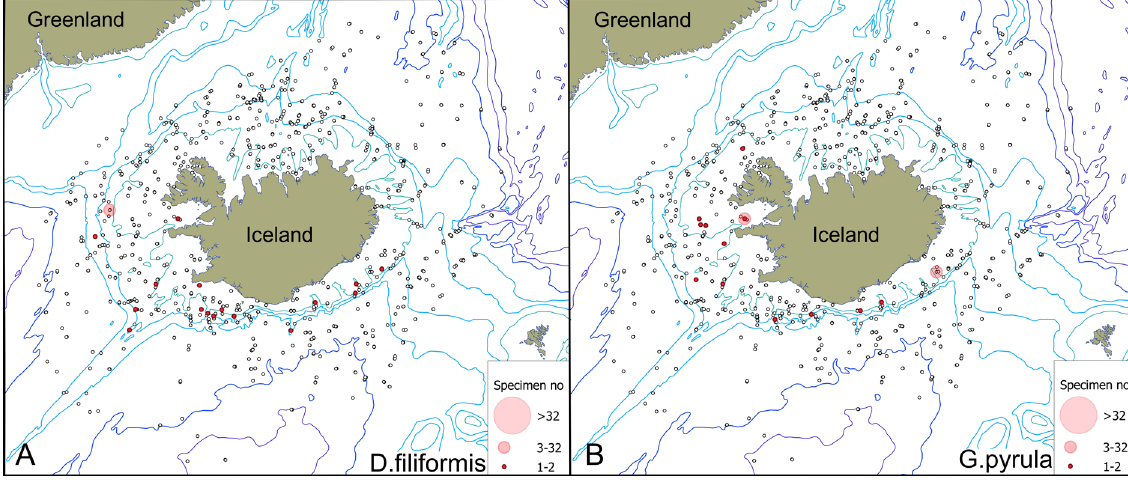
Fig. 21. Species distributions based on BIOICE samples (Icelandic waters). A . Dentalina filiformis (d’Orbigny, 1826). B . Grigelis pyrula (d’Orbigny,